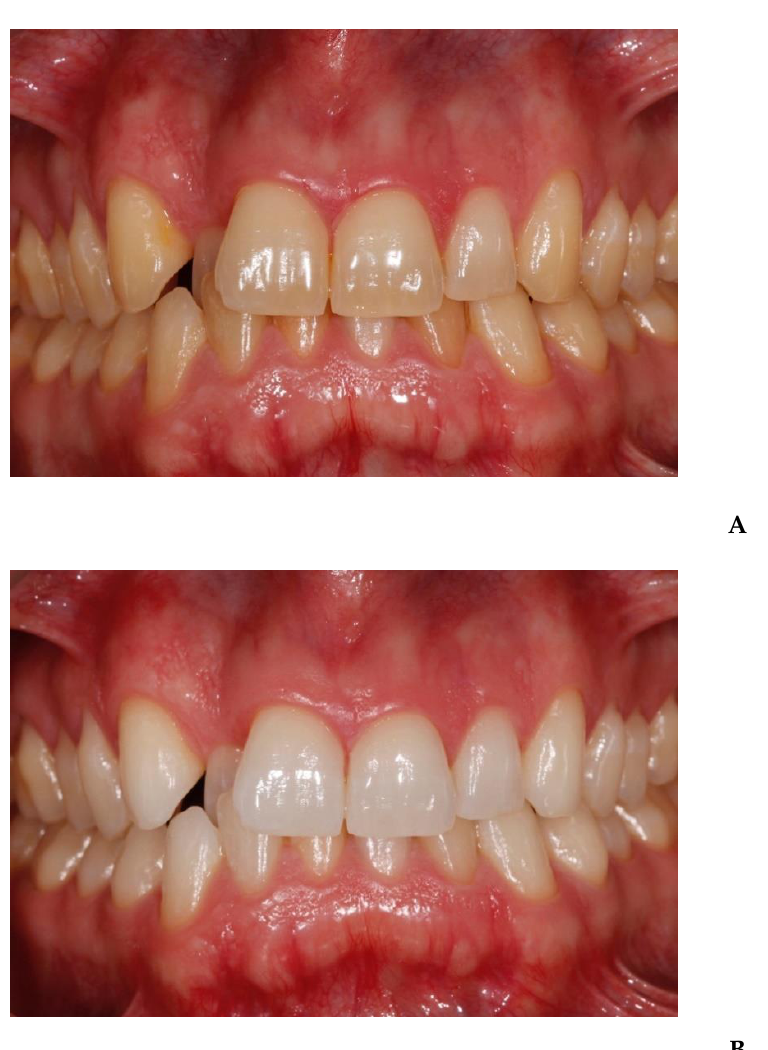
Figure 5. Group 3 patient (38% HP, Pure, Axis Dental): ( A ) pre-treatment image; ( B ) post-treatment image.